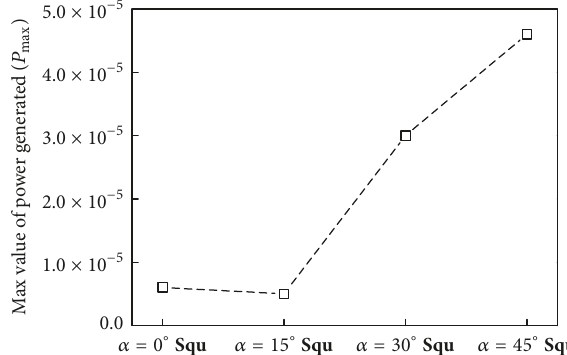
Figure 22: Comparison of maximum value of power output between VIVPEH with different